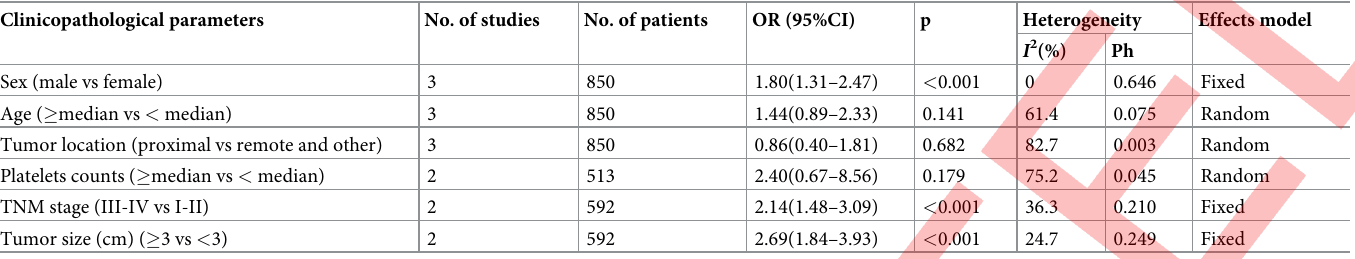
Table 3. Association between high levels of CAR and clinicopathological characteristics of patients with